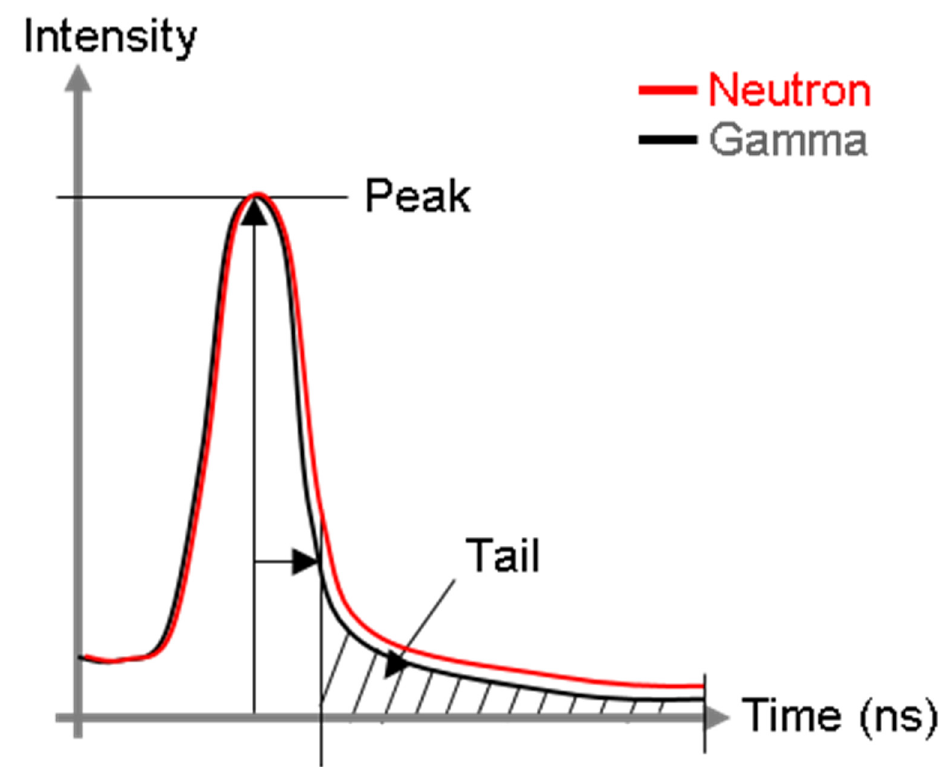
Figure 5. Example plot of normalized electrical pulses measured from the detectors. The peak is the highest intensity of the electrical pulse, and the tail is the integral value after the peak and the delay time.